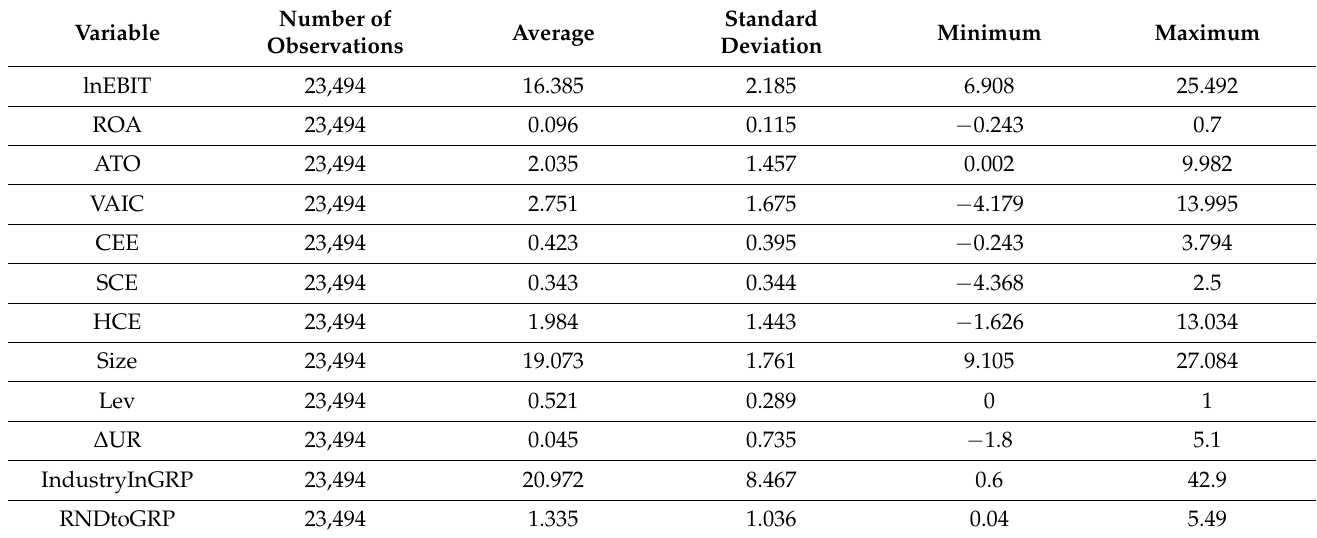
Table 2. Descriptive statistics of a sample of manufacturing enterprises in